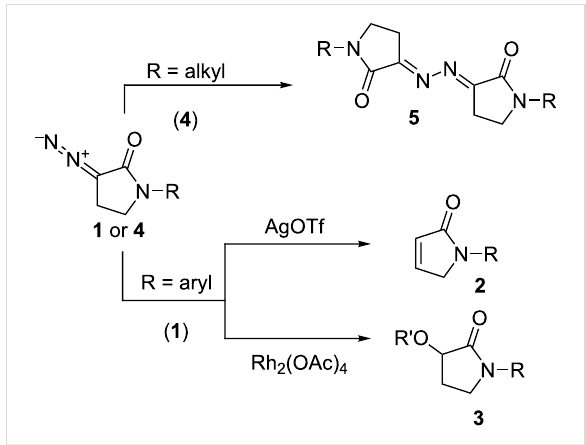
Figure 1: Previously reported uses of α -diazo- γ -butyrolactams 1 and 4